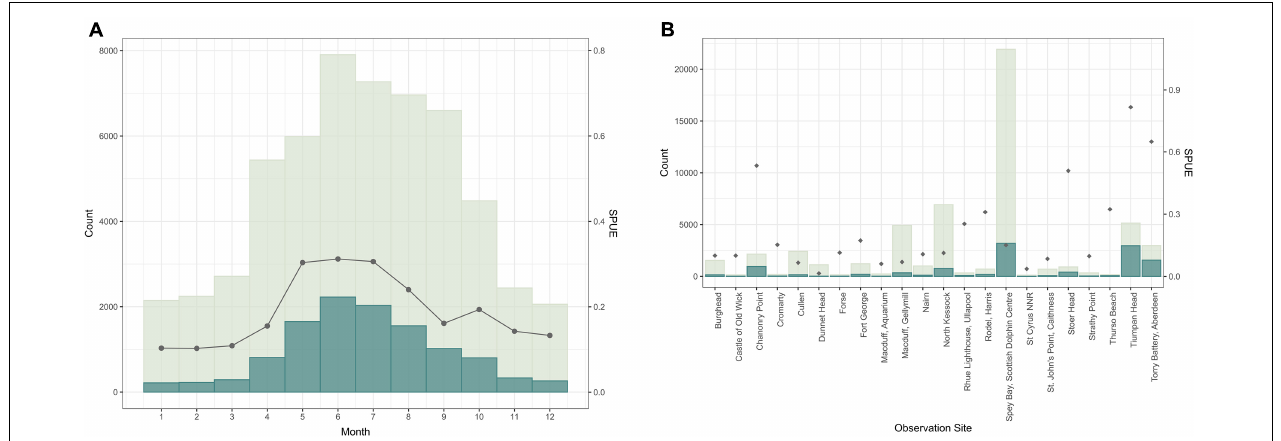
FIGURE 3 | Number of sightings of all the cetacean species for those observation sites with more than 100 watches in relation to (A) month and (B) observation site (scaled on the left y -axis). The number of sightings is shown in dark blue and the distribution of total effort (number of watches) is shown in light gray. Sightings per unit of effort (SPUE) are indicated by dark gray dots, scaled on the right y